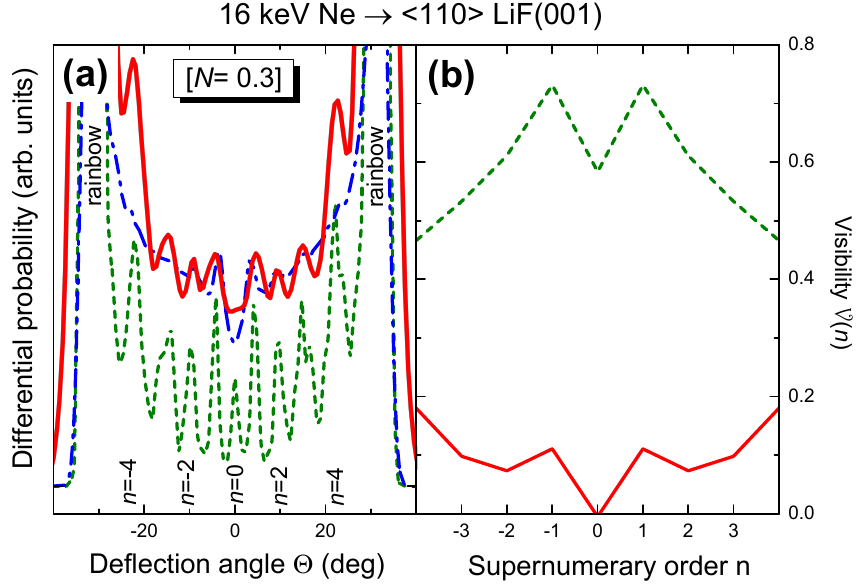
Figure 8. (Color online) Analogous to Figure 7 for E = 16 keV [ N = 0.3 ] . Blue dot-dashed line, classical projectile distribution for N =